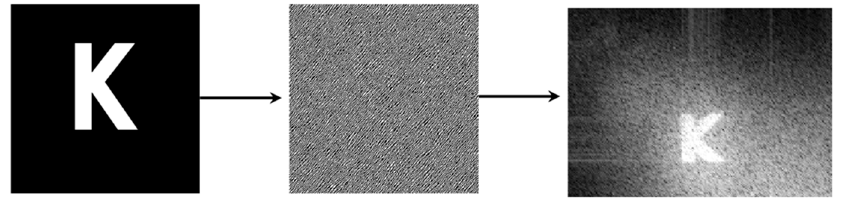
Figure 2. CGH Synthesis and read-out of the original logo “K”.